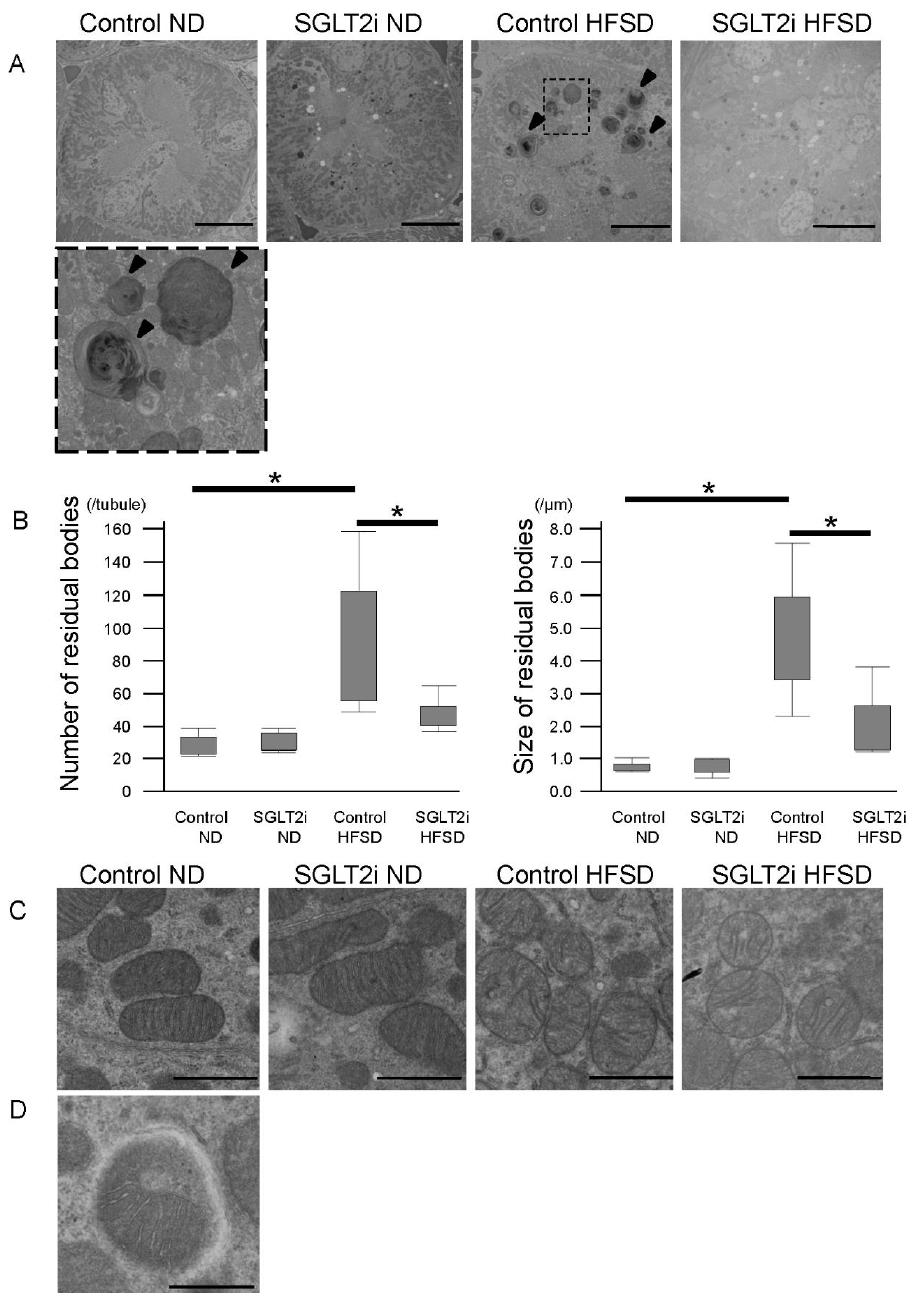
Figure 5. SGLT2 inhibitor (SGLT2i) decreased multi lamellar bodies (MLBs) and increased autophagosomes in renal proximal tubular cells (PTCs) of obesity mice. ( A ) PTCs in transmission electron microscopy images; arrowhead: MLBs; bars: 10 µm. ( B ) Quantitative analysis of residual bodies in PTCs. Results are presented as the mean ± standard deviation. Differences were evaluated by two-way ANOVA followed by Tukey–Kramer test (* p < 0.05). ( C ) Mitochondria in PTCs of transmission electron microscopy images; bars: 1.0 µm. ( D ) Mitophagosomes in PTCs of HFSD-fed mice treated with SGLT2i; bars: 500 nm. SGLT2i: empagliflozin.